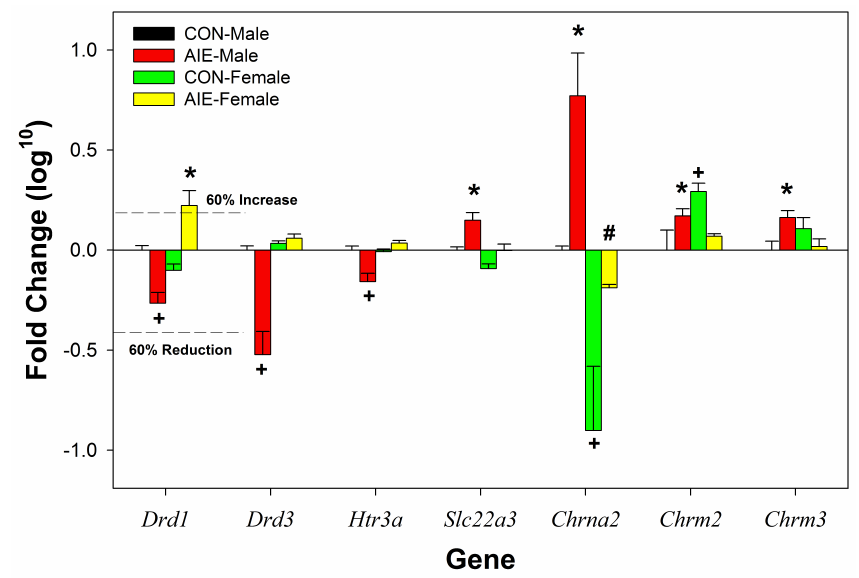
Figure 3. Fold change (log10 normalized to CON males) expression for DA and Ach related genes in the AcbSh in adult CON and AIE male and female Wistar rats. * indicates significantly greater expression compared to CON-Males. + indicates significantly lower expression compared to CON- Males. Data are mean ± SEM.